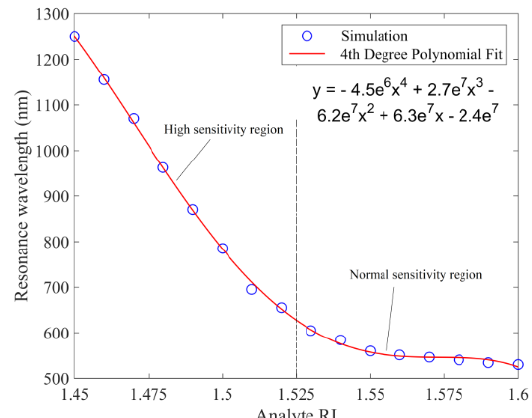
Figure 15. Loss peak wavelength or resonance wavelength as a function of analyte RI for a D-shaped PCF-based plasmonic biosensor. Reproduced with permission from Reference [37], Copyright 2019, IEEE.